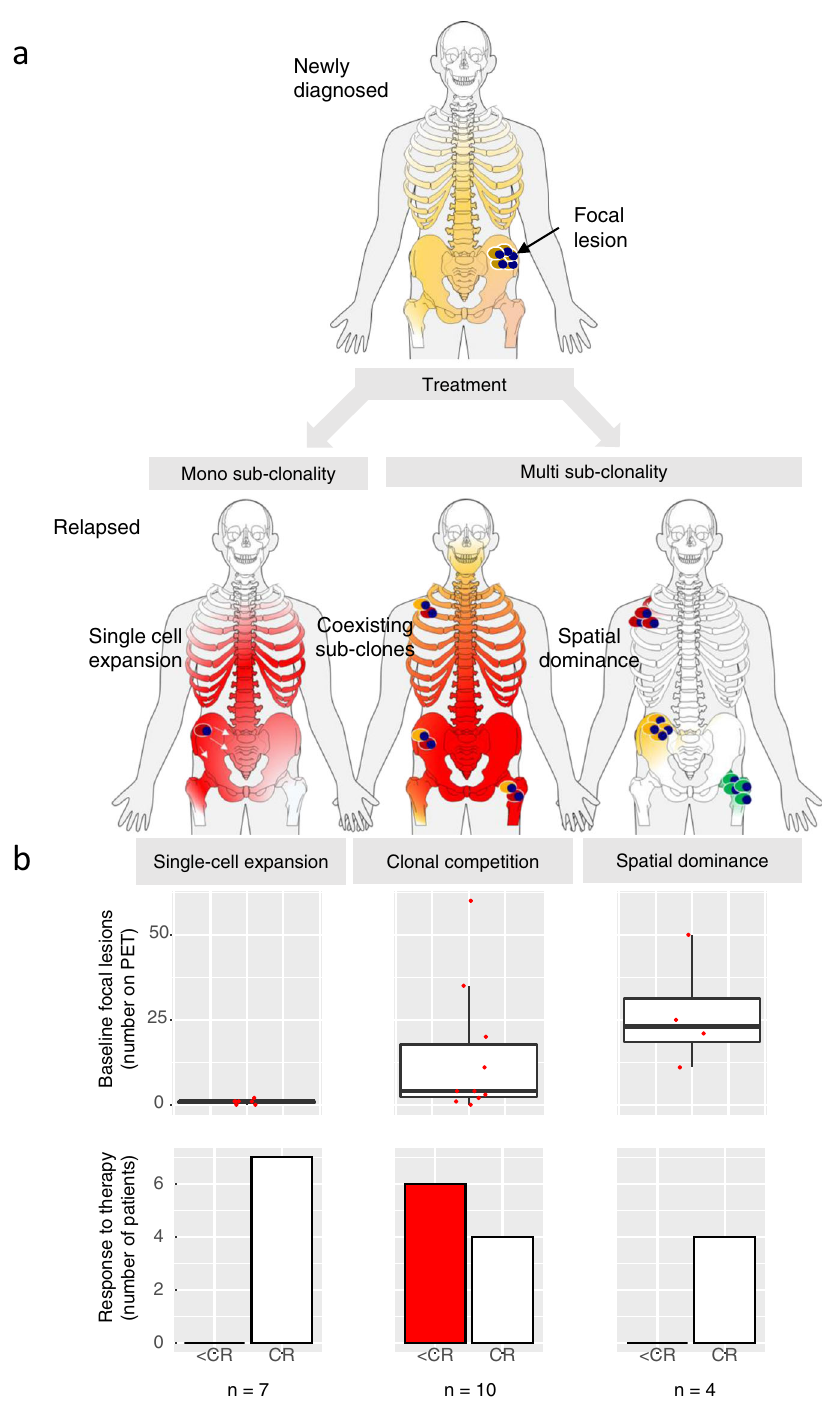
Fig. 6 | Evolutionary patterns and association with clinical features. In a the three evolutionarypatterns,whichwe observedinthis study, are illustrated. These include (1) expansion and sweep driven by single tumor cells, (2) coexisting expandingsubclones,and(3)site-uniqueexpansionsofdistinctsubclones,withthe main difference between the second and the third pattern being the anatomical location of subclones. In b , boxplots are shown for the association between these